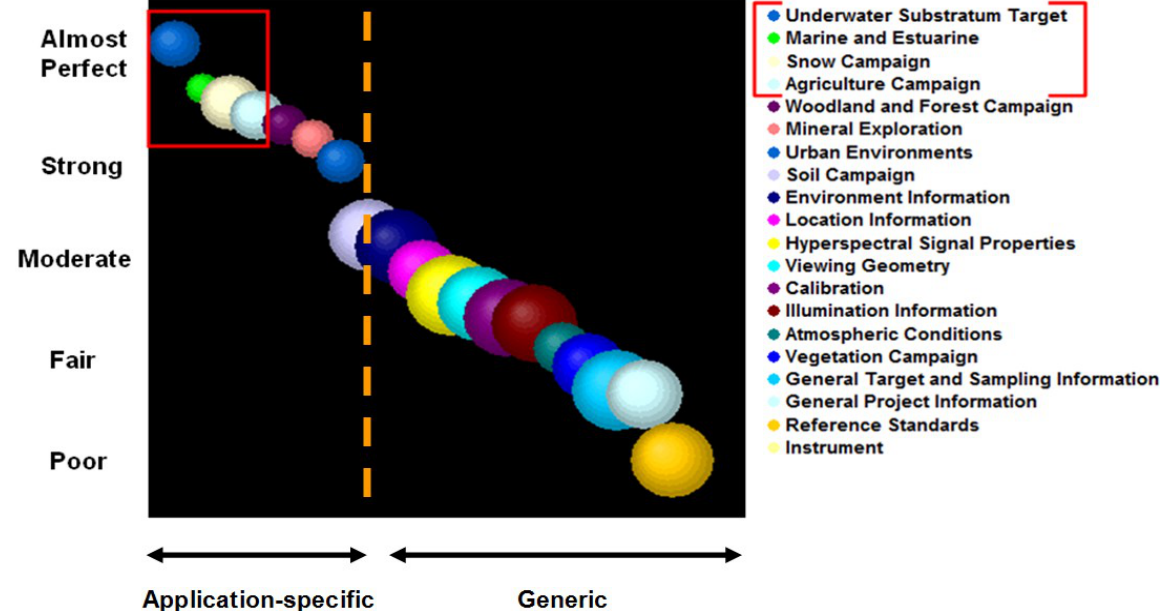
Figure 7. Group consensus measure for metadata field criticality among the respondents, from highest consensus (―almost perfect‖) to lowest (―poor‖), across the metadata categories. Size of category denotes respondent population